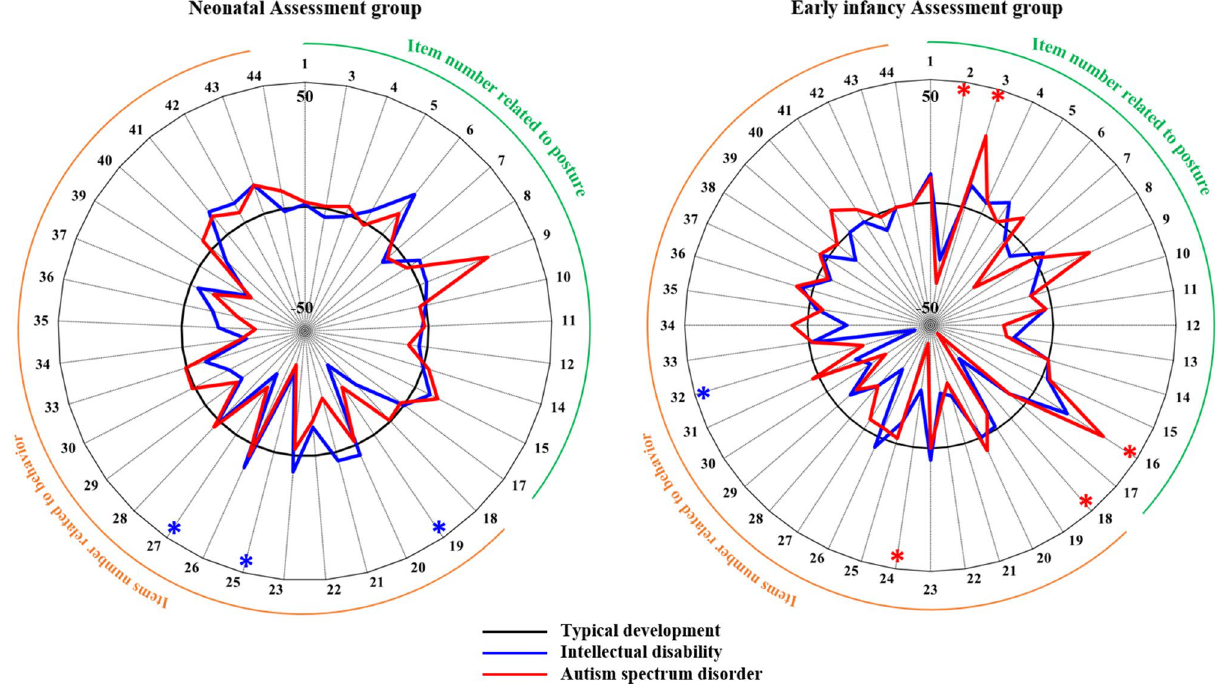
Figure 1. Radar chart of the difference percentage between the typical development group and the other group at NA and EA terms. The red and blue line shows the distribution of the difference of percentage of participants for whom the posture and behaviour appeared. Each line represents the value of the TD group minus the value of the ID and the ASD group (note that the values of the TD group are all zero and the values have no units). * p < 0.05 in comparison with the TD group using Fisher’s exact test corrected by the Benjamini–Hochberg